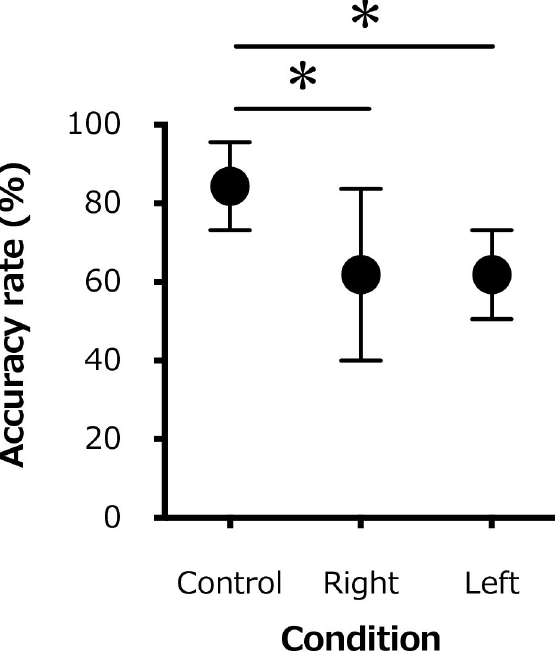
Fig 3. Changes in the average accuracy rate of detection for the 20 repetitions of the monofilament test of all participants for the control (rest) condition, the active contraction (right) side, and the contralateral (left) side. � , P <